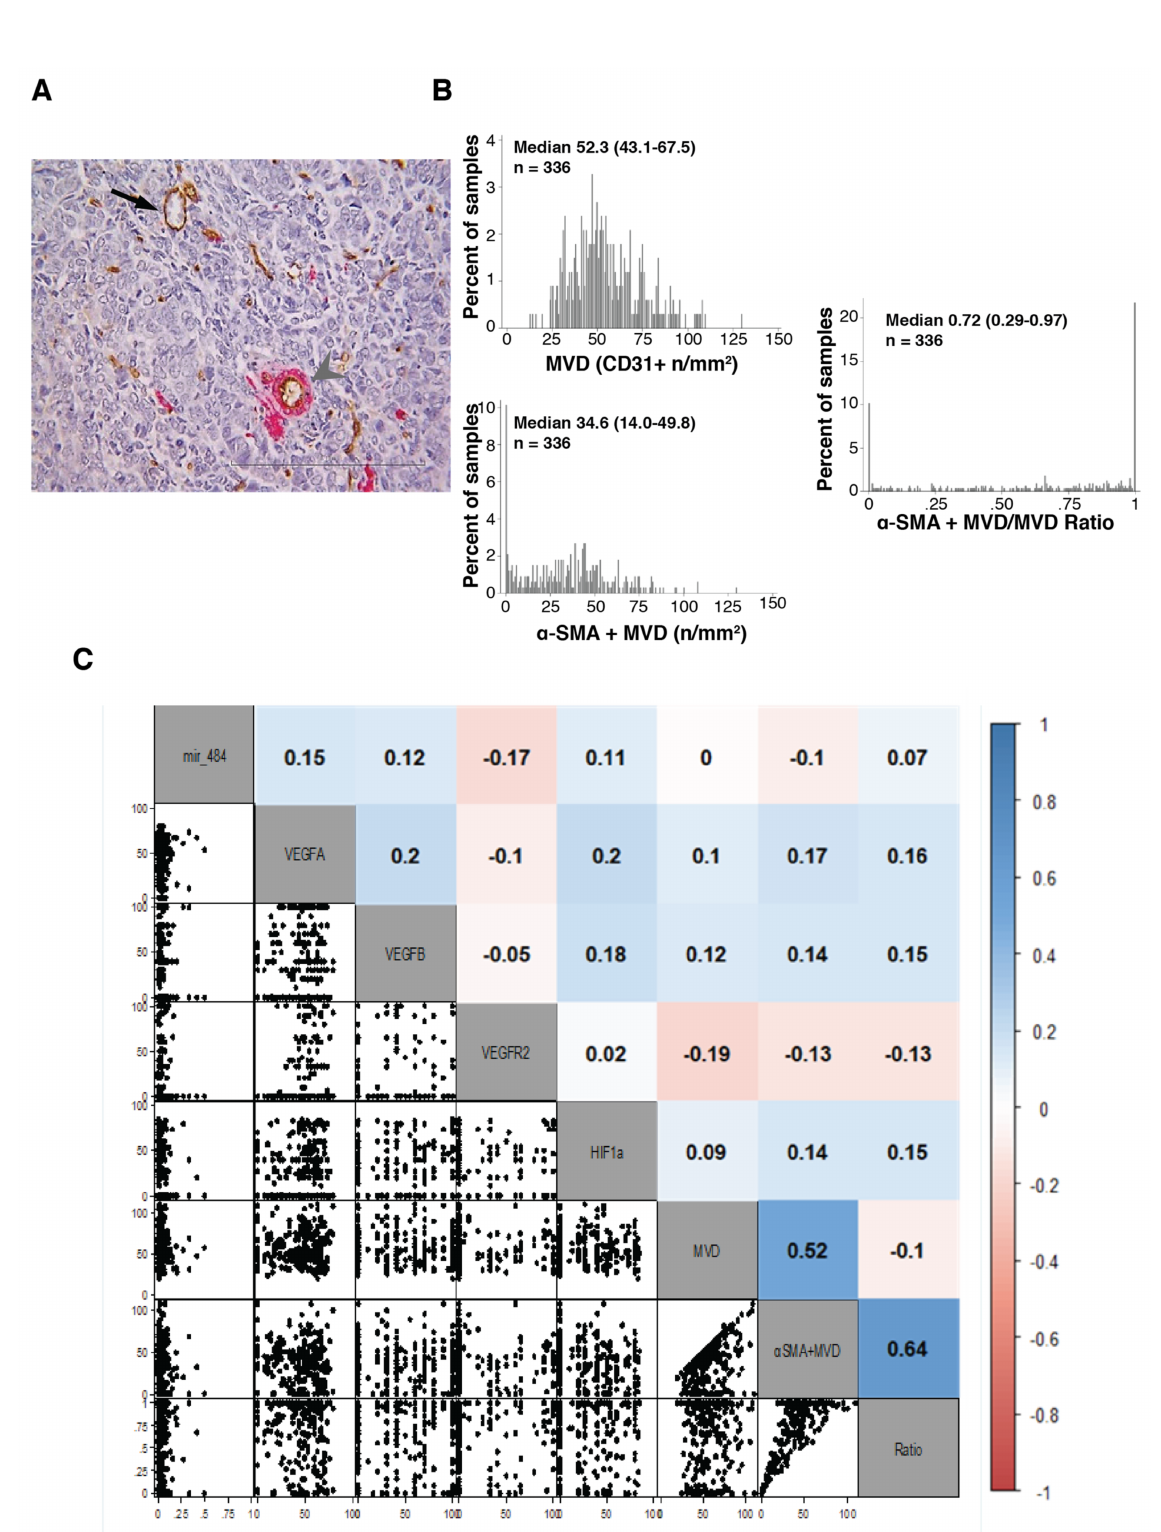
Figure 2. Evaluation of MVD in MITO16A population and its correlation with selected angiogenesis-related genes. ( A ). Representative picture showing CD31-positive intratumoral microvessels (arrow) and CD31-positive entities associated with α -SMA positive cells (arrowhead) (magnification 40 × , scale bar 100 µ m). The microvessel density (MVD) and the α SMA+ microvessel density ( α SMA + MVD) were expressed as mean number of vessel per mm 2 . ( B ). Distribution of CD31 and α -SMA expression in the analyzed samples. On the left, the distribution of α -SMA + MVD/MVD ratio is shown. ( C ). Pairwise distribution of biomarkers. The correlogram plot reports the Kendall’s tau values. On the right is shown the color scale